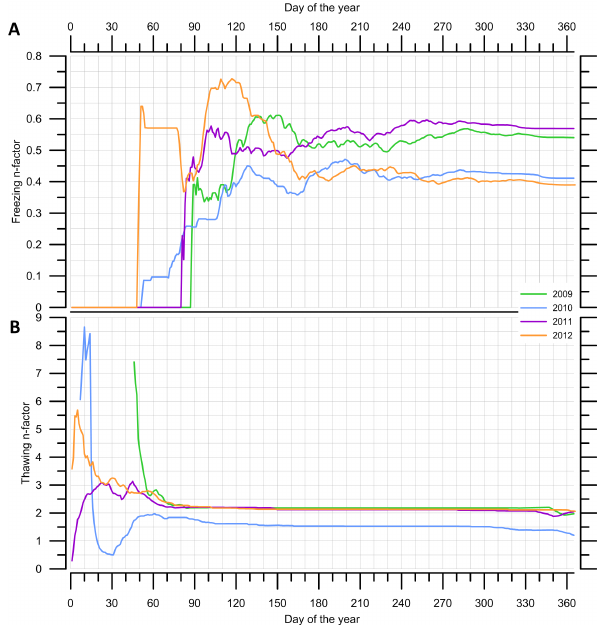
Figure 9. Freezing (top) and thawing (bottom) n factors for the dif- ferent